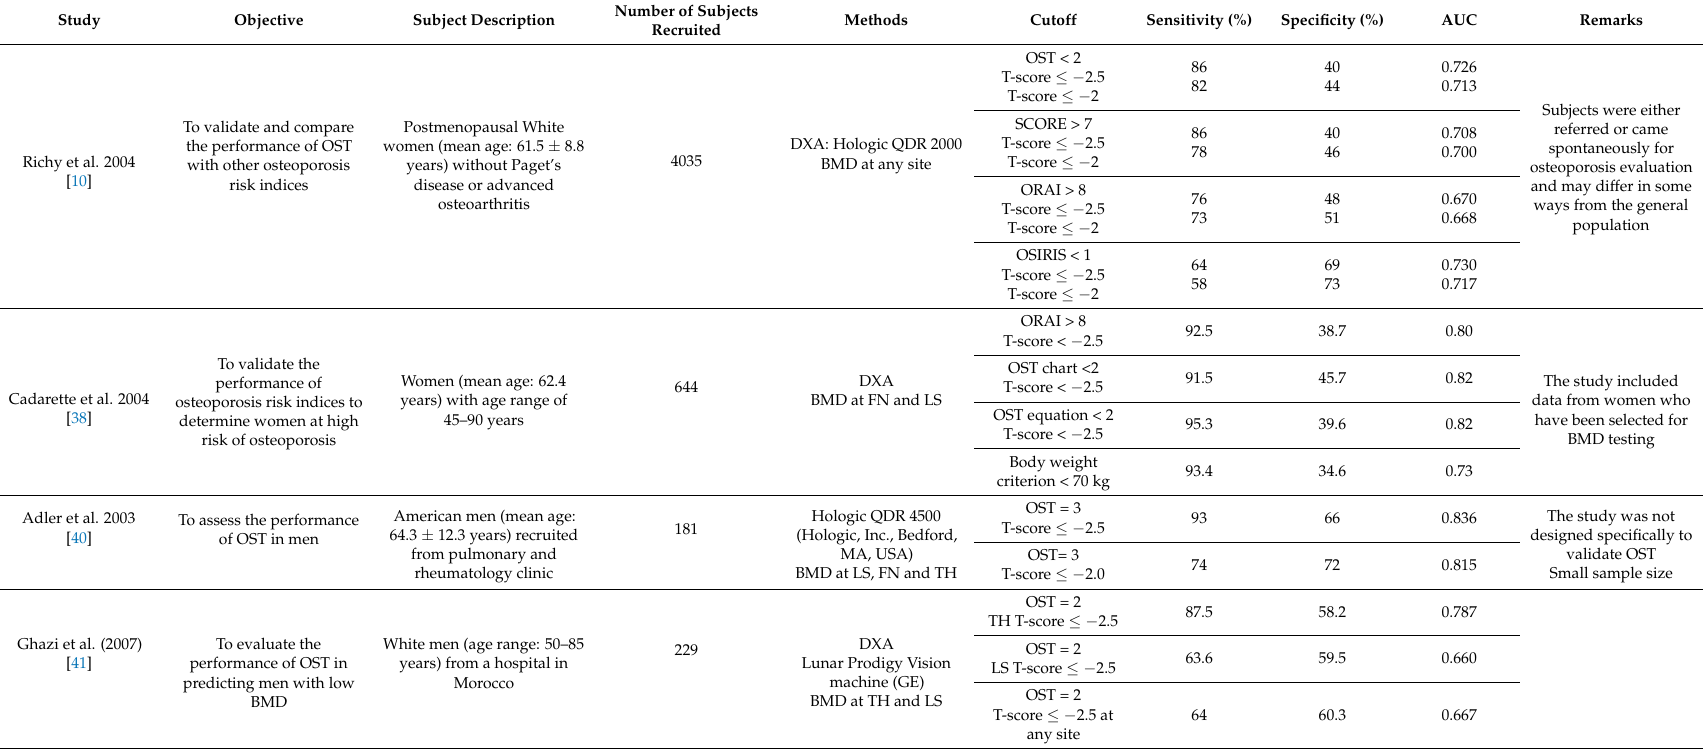
Table 2. Performance of OST for